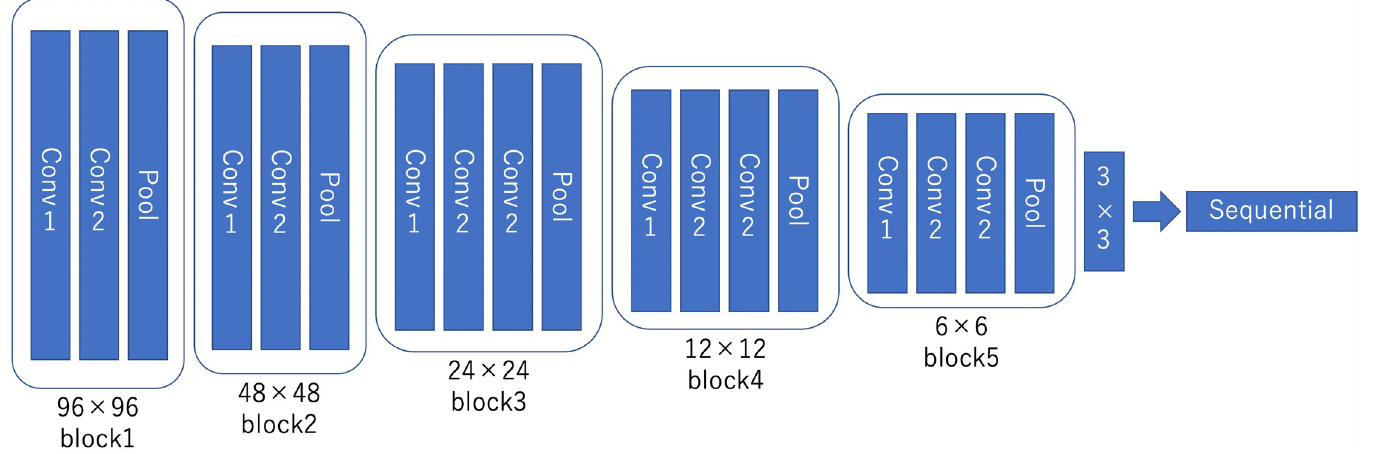
Fig 2. Scheme of the convolutional neural